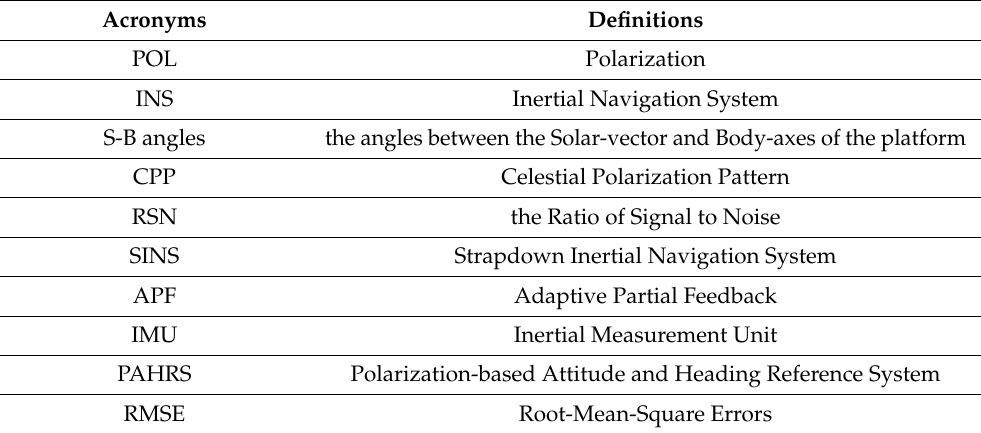
Table 2. Nomenclature.